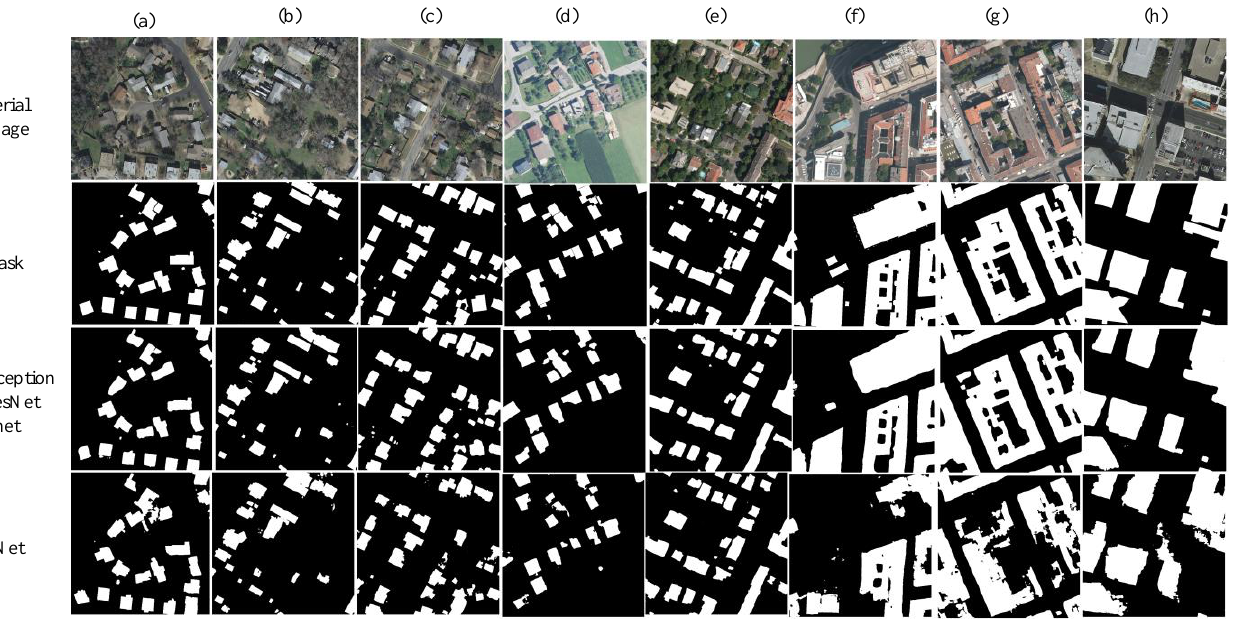
Figure 6. From (a) to (d), some buildings of small size are detected in Inception ResNet UNet, but UNet couldn’t detect them precisely. In (f), large buildings are not detected in UNet properly, though the Inception ResNet UNet detects them more accurately. Some shadows were detected as part of building in (h) in UNet, whereas Inception Resnet UNet could handle relief displacement.